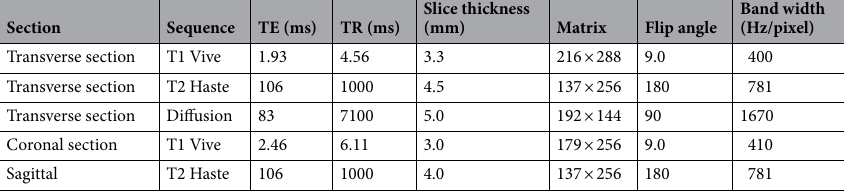
Table 2. Sequence